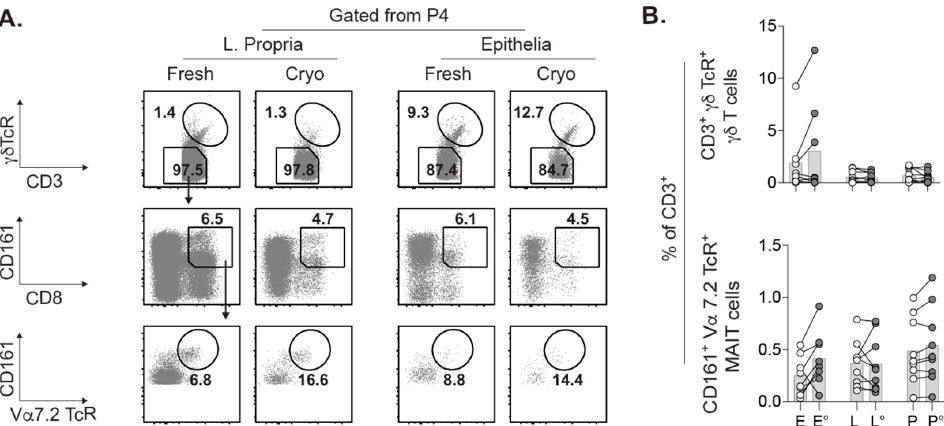
Figure 3. Quantification of unconventional γδ T cells and MAIT cells. ( A ) γδ T cells expressing γδ TcR from total CD3+ TILs ( P4 in Figure 1B). CD161+ V α 7.2 TcR+ MAIT cells are from the CD8+ TILs contained in the CD3+ γδ TcR– population. Percentages of parent population shown. ( B ) Frequencies of intratumoral γδ T cells and MAIT cells and their counterparts in PBMCs within total T cells. E, L, and P denotes epithelia, lamina propria, and PBMC, respectively. ◦ indicates cryopreserved samples. Bars show the mean. Welch’s t